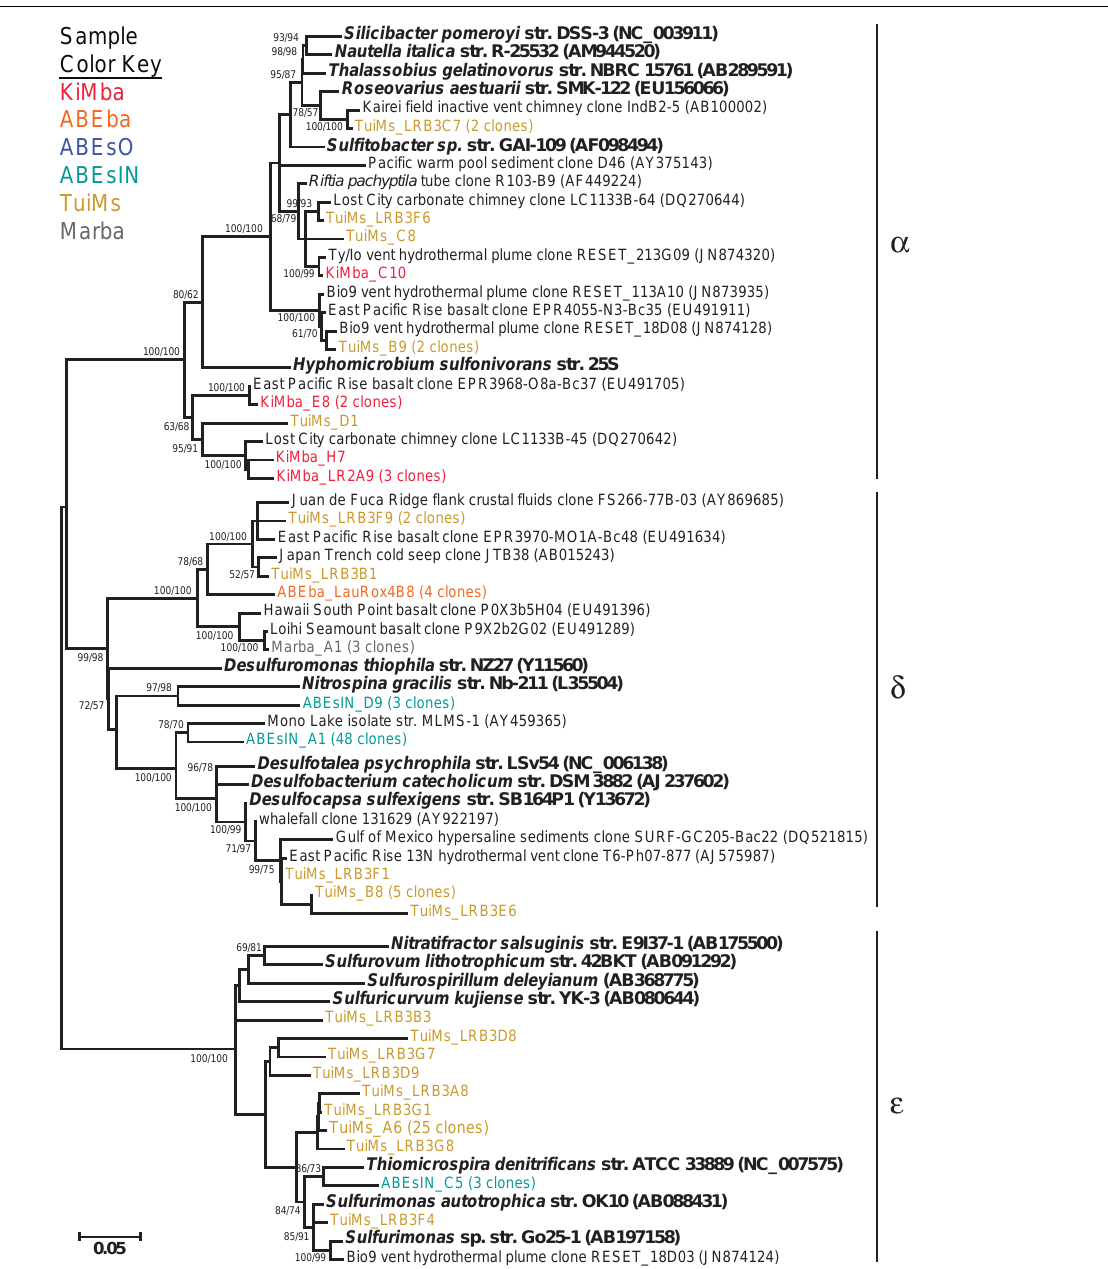
FIGURE 6 | Phylogenetic tree of representative clones from this study that fall within the α -, δ -, and ε -proteobacteria. Clones with more than one representative, or for which multiple members fell into a single clade, were chosen. Numbers in parentheses after some clones indicate total number of clones represented by the single clone depicted.The tree was generated in MEGA 5 using the maximum likelihood method with the Jukes–Cantor model and a Gamma distribution and 1000 bootstrap